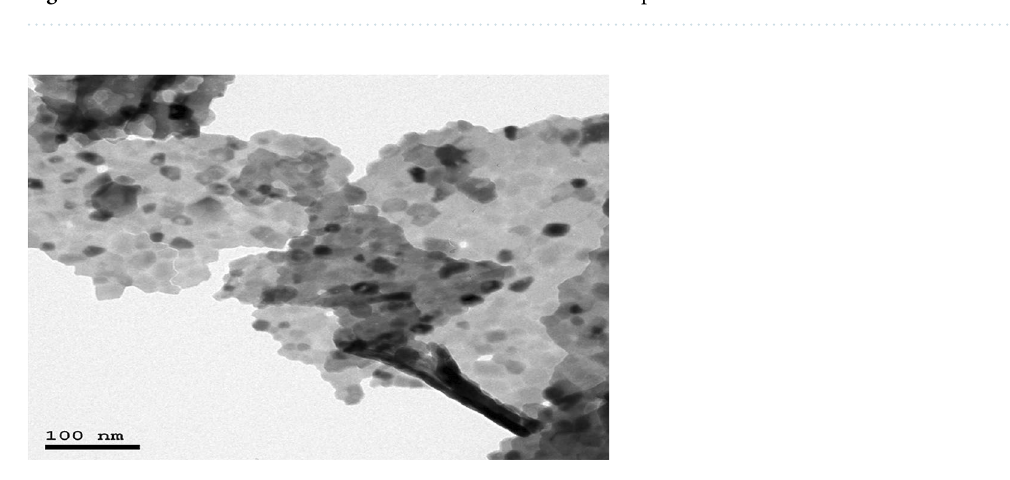
Figure 2. Zeta Potential and Size distribution of Erbium Oxide nanoparticles.